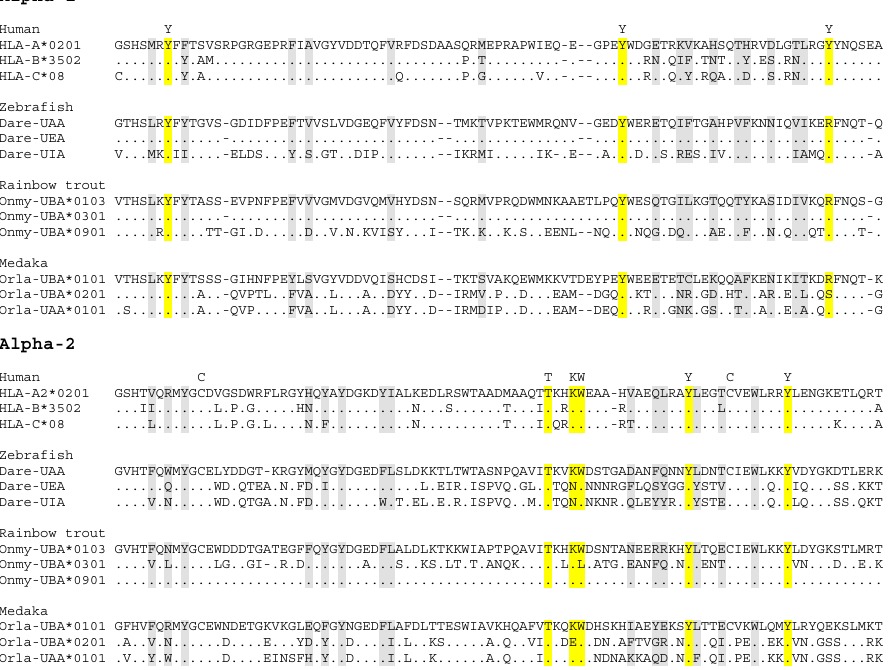
Figure 2. Alignment of deduced classical MHC class I α 1 + α 2 domain amino acid sequences. This